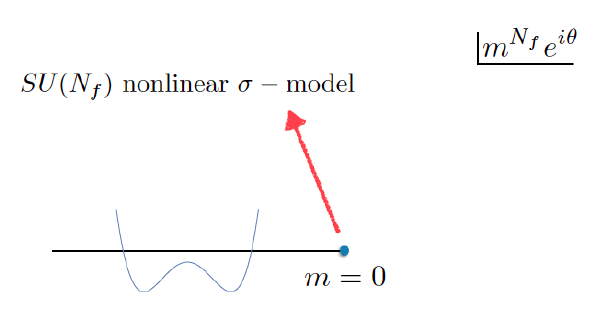
Figure 3 . The phases of QCD with N f > 1 degenerate (cid:13)avors. At m = 0 the global SU( N f ) (cid:2) SU( N f ) symmetry is spontaneously broken to the diagonal SU( N f ) and the low energy theory is gapless. For positive m and (cid:18) = (cid:25) there are two vacua and for generic (cid:18) there is a single vacuum. Unlike N f = 1, here the (cid:17) 0 particle is never